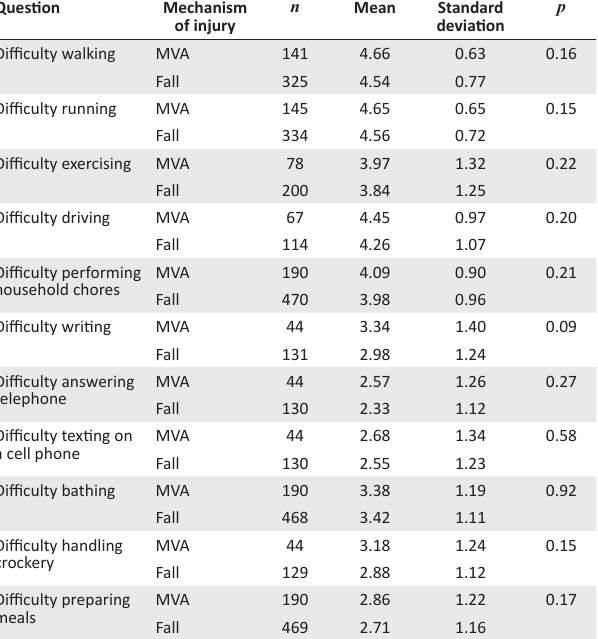
TABLE 4: Pooled analysis – The physical impact of the long bone fracture: Motor vehicle accidents versus falls ( n =